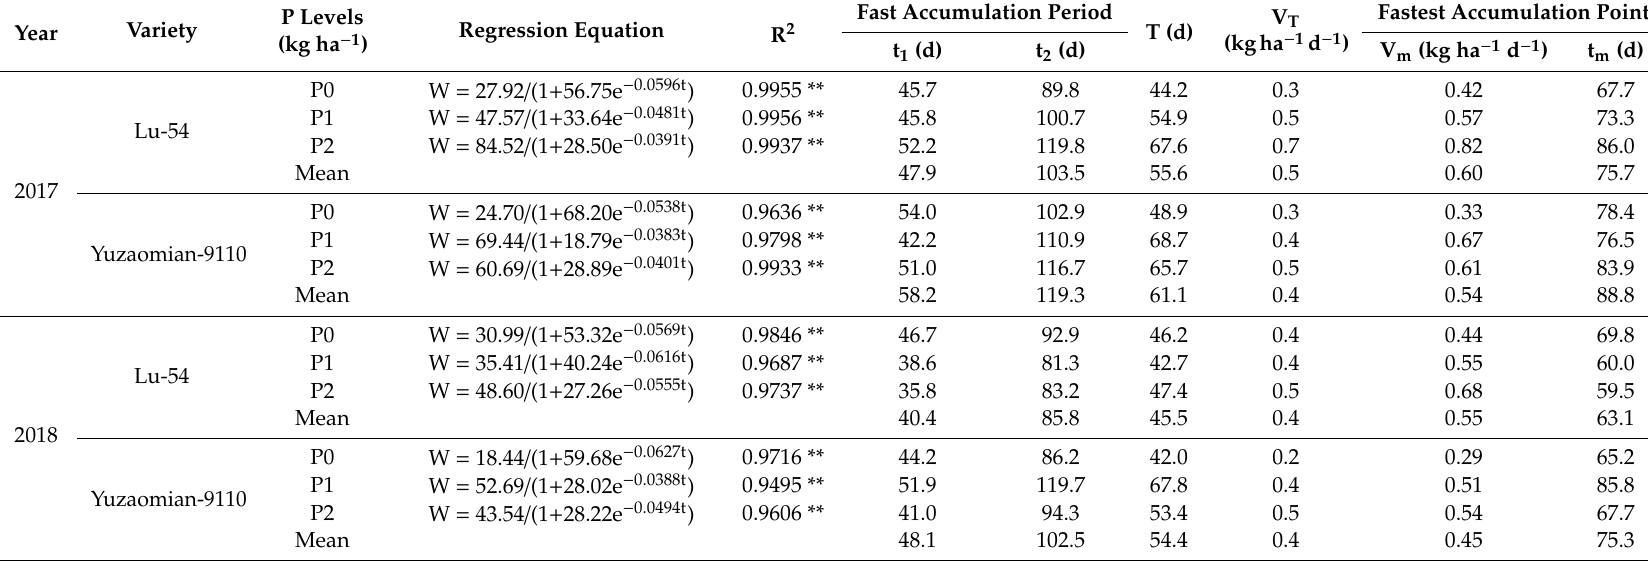
Table 3. Dynamic models and the maximum accumulation rate of P (V M ), average speed of P accumulation (V T ), start time of the P rapid-accumulation period (t 1 ), termination time of the P rapid-accumulation period (t 2 ), duration of the P rapid-accumulation period (T), and occurrence time of maximum accumulation rate of P (t m ) in reproductive organ of cotton plants for Lu-54 and Yuzaomian-9110 in 2017 and